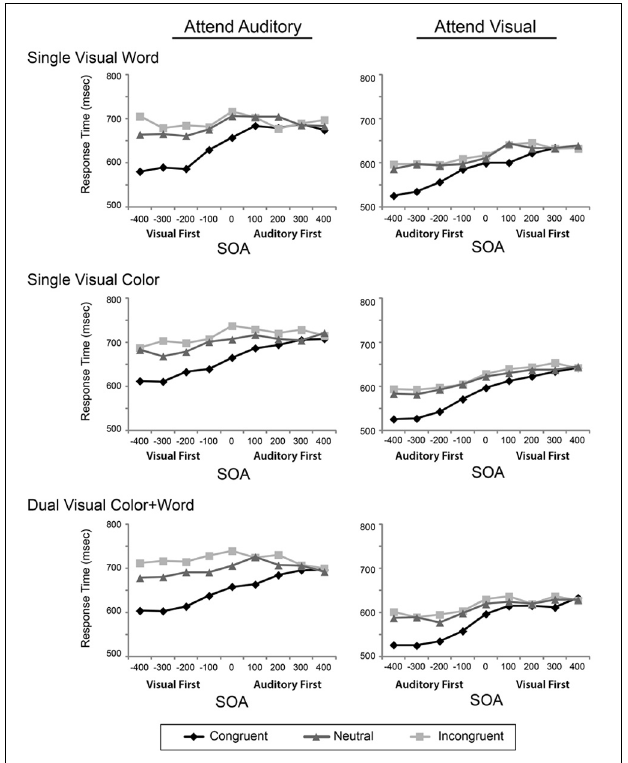
FIGURE 2 | Reaction times for the congruent, neutral, and incongruent conditions are plotted across the 9 SOAs, presented in separate rows for each visual feature combination, and in separate columns for the two attentional